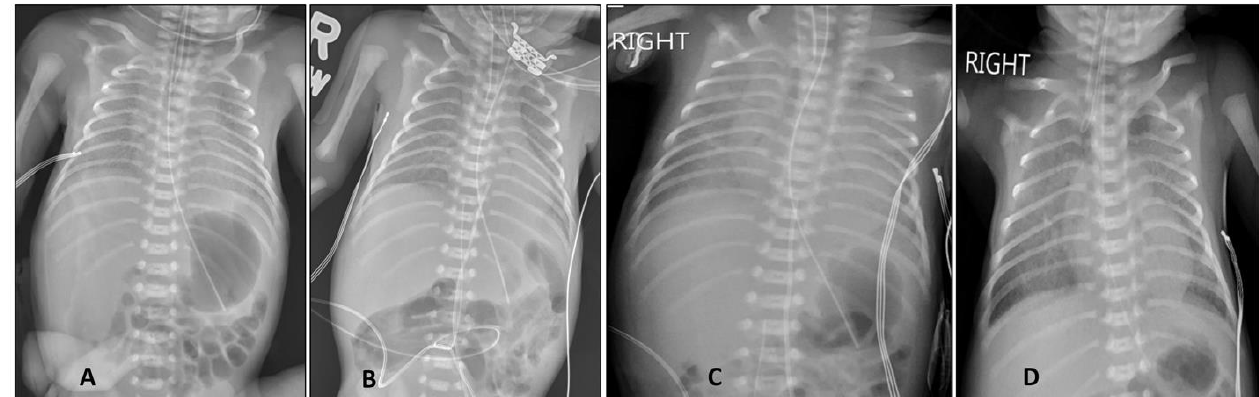
Figure 1. Progression of chest X-ray in the first two weeks after birth. ( A ). Chest X-ray soon after birth demonstrated low lung volumes and air bronchograms from hyaline membrane disease. ( B ). Chest X-ray at 48 h of age demonstrated better lung expansion after three doses of intratracheal surfactant administration. ( C ). The infant was in hypoxic respiratory failure, requiring 100%O 2 on day 5 after birth. Chest X-ray revealed significant bilateral opacities with low lung volumes. ( D ). A dexamethasone course significantly improved lung aeration, with decreasing lung opacities on day 12 after birth. Table 1. SARS-CoV-2 test results and viral quantification by cycle threshold (Ct) values by real-time PCR over